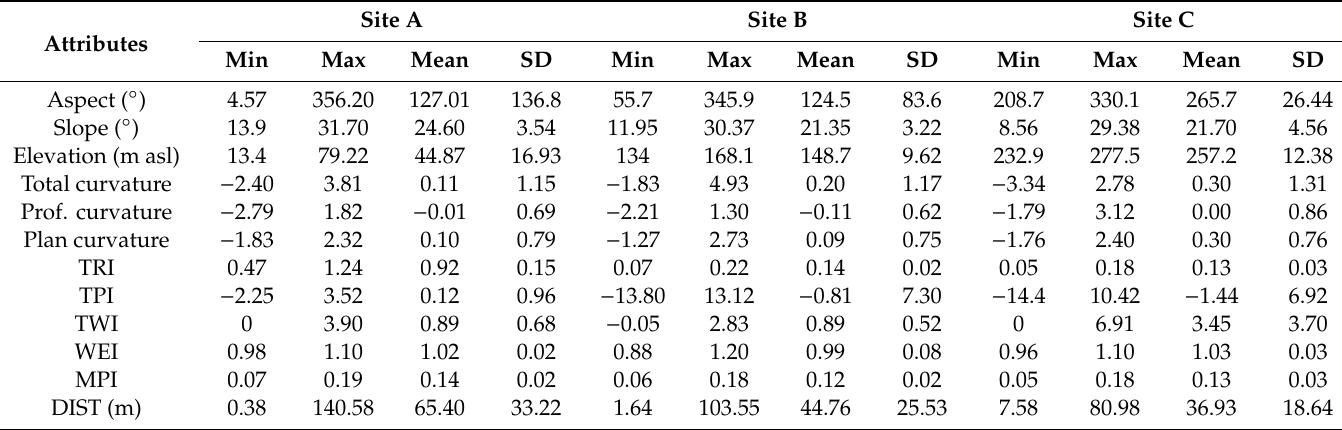
Table 3. Summary of the topographic attributes for study sites. TPI—topographic ruggedness index; TRI—topographic position index; TWI—topographic